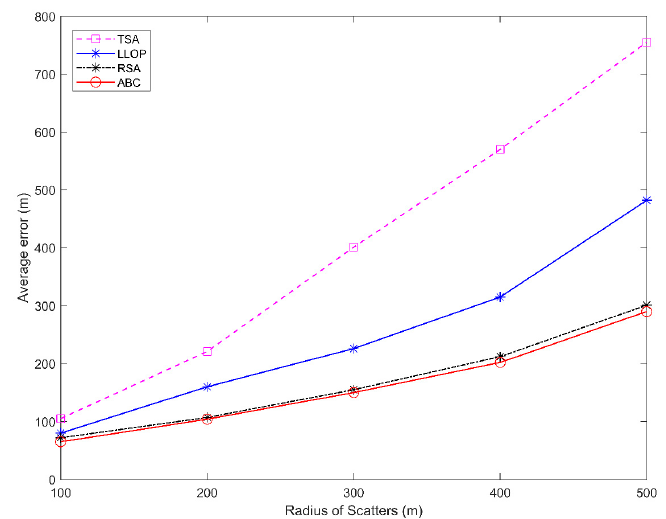
Figure 6. Average location error versus the different radius of scatters.